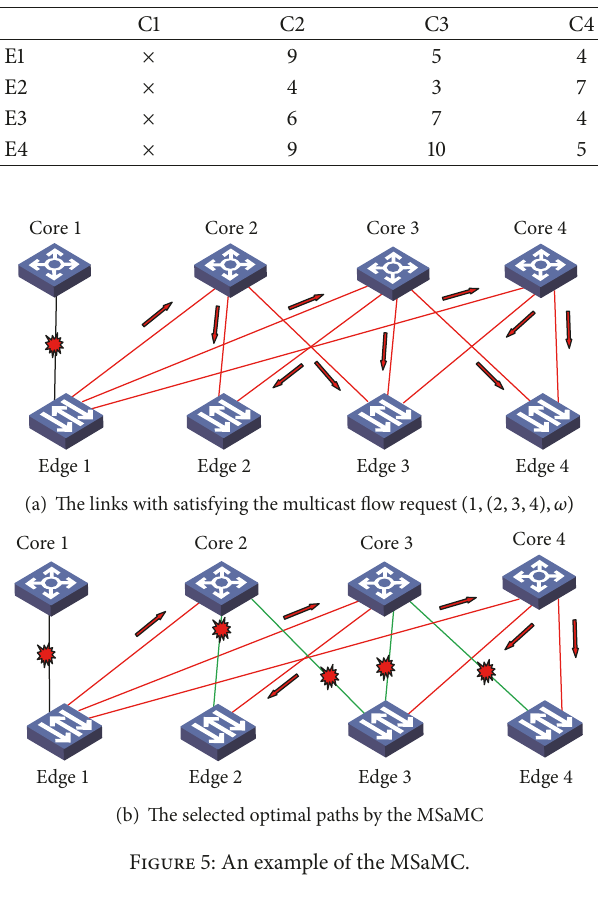
Table 2: The link blocking probability at next time-slot (%).